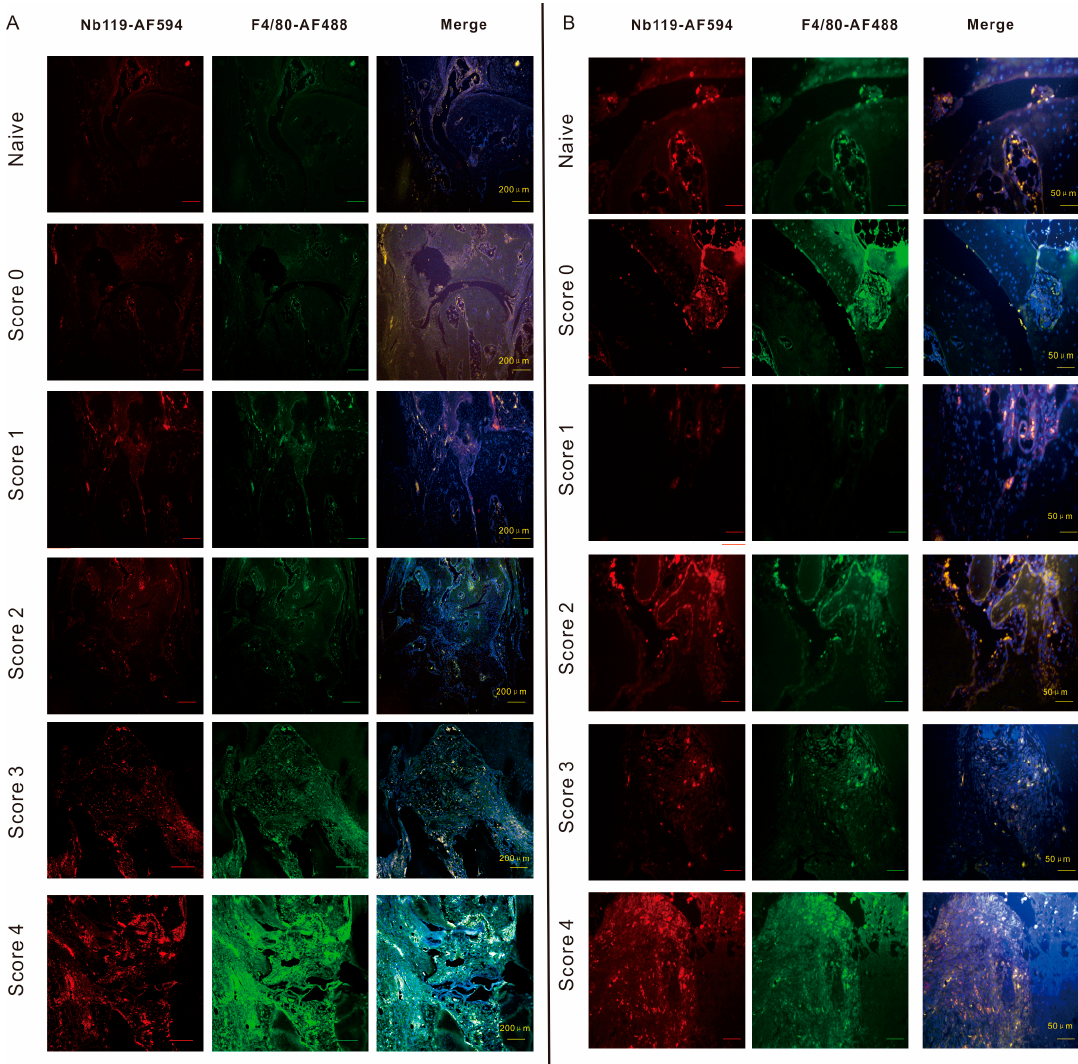
Figure 5. Confocal microscopy demonstrates that Vsig4 + F4/80 + macrophages increased according to the severity of arthritis. Immunofluorescence microscopy of CIA joints left hind ankles having different clinical scores. DBA-1 mice were immunized with type II collagen in complete Freund’s adjuvant. Slides were incubated with Nb119 labelled by AF549 (red) and AF488-labelled anti-F4/80 (green). Cell nuclei were stained with 4 ′ ,6-diamino-2-phenylindole (DAPI) dye (blue), colocalization of F4/80 and Vsig4 were shown in the third panel (white). ( A ) Scale bar = 200 μ m. ( B ) Scale bar = 400 μ m. Photomicrographs of left hind ankles from representative 5 mice are shown for each clinical score group.